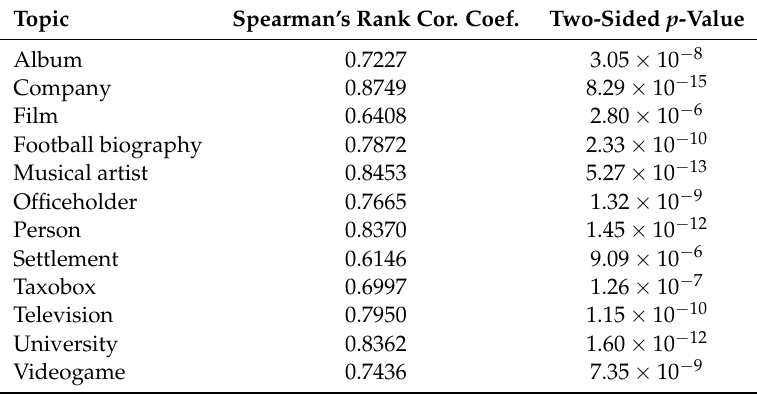
Table 12. Spearman’s rank correlation coefficients for shares of the articles of the highest quality and popularity, on various topics. Source: own calculation using